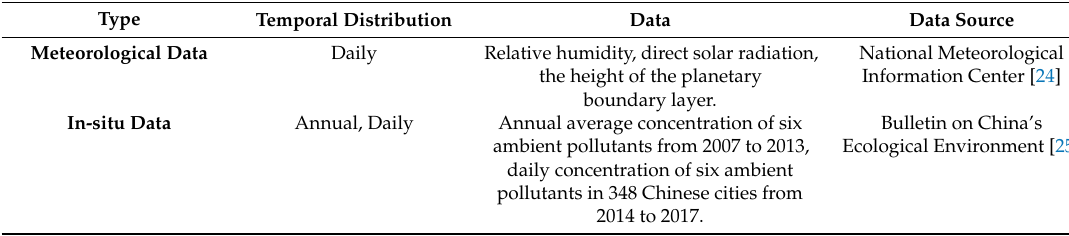
Table 3. The data source of ground-based measurements used in this study.